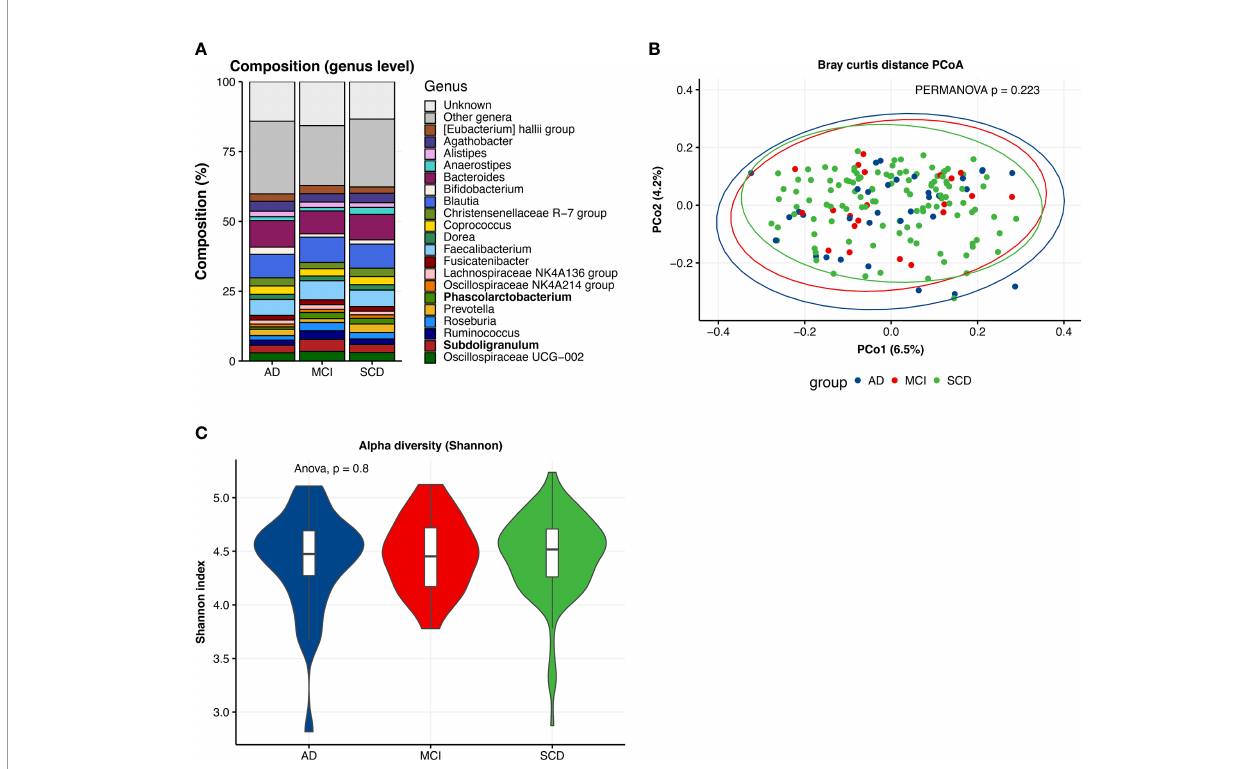
FIGURE 2 | Descriptive characteristics of microbiota composition, differences between diagnosis groups. (A) Compositional plot of top 20 genera with bars representing diagnosis groups: Alzheimer ’ s disease dementia (AD), mild cognitive impairment (MCI) and subjective cognitive decline (SCD). “ Unknown ” refers to ASVs of which taxonomy was not known up to genus level. Genera with different abundances across groups (Kruskal-Wallis test, p <0.05) are marked in bold. (B) Principal coordinate analysis (PCoA) plot of Bray-Curtis distances per diagnosis group with PERMANOVA test for group differences. (C) Alpha diversity (Shannon index) of gut microbiota composition per diagnosis